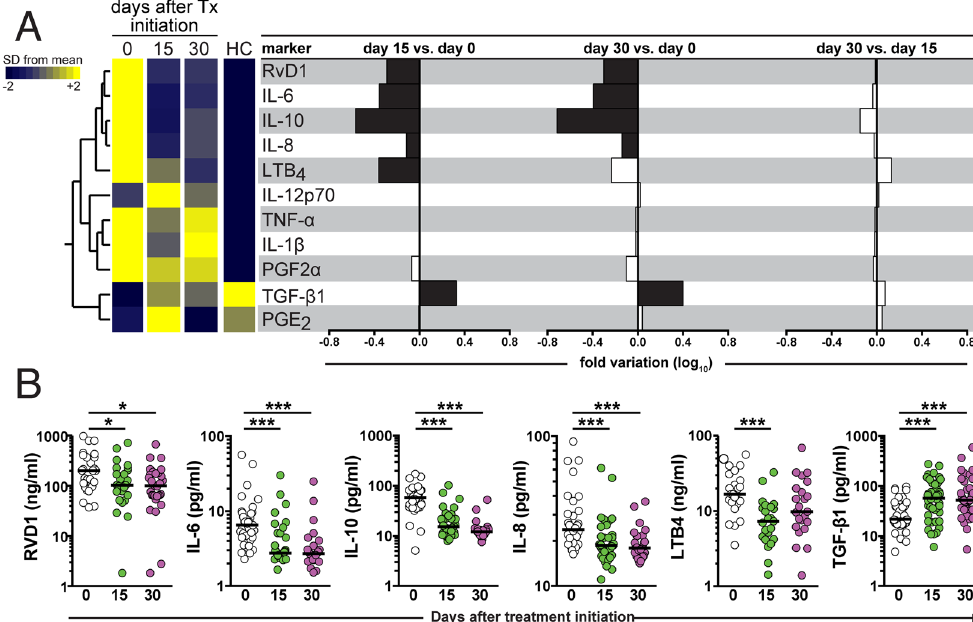
Figure 1. Serum concentrations of prostaglandins and cytokines in treatment-naïve patients with visceral leishmaniasis. ( A ) A hierarchical clustering analysis (Ward’s method) was employed to depict the overall expression profile of PGE 2 , PGF 2 α , LTB 4 and RvD1, as well as the cytokines IL-1 β , IL-6, IL-8, IL-10, IL- 12p70, TNF- α , and TGF- β 1 in serum from visceral leishmaniasis (VL) patients at different timepoints of leishmanicidal therapy and health endemic controls (HC). Fold changes were calculated and statistically significant differences are highlighted in black. ( B ) Parameters that displayed statistically significant differences between the timepoints tested by one-way ANOVA with Tukey’s post-test (after log10 transformation) are shown. Additional details of the comparisons are described in Tables 2 and